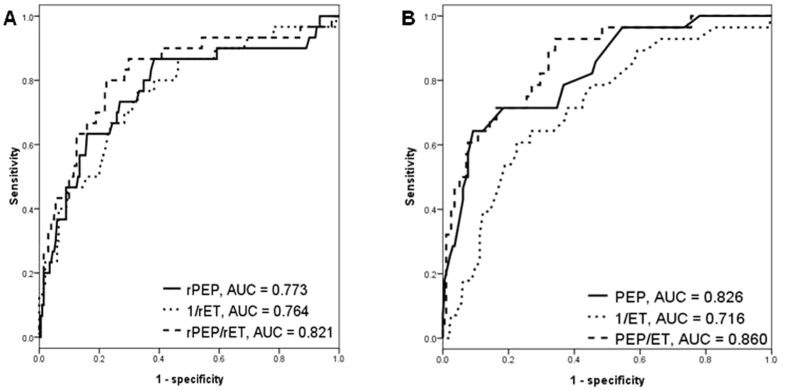
The areas under the curve (AUCs) for renal pre-ejection period (rPEP), 1/renal ejection time (rET), and rPEP/rET measured from renal Doppler ultrasound (A) and pre-ejection period (PEP), 1/ejection time (ET), and PEP/ET measured from echocardiography (B) in prediction of left ventricular ejection fraction <50%.